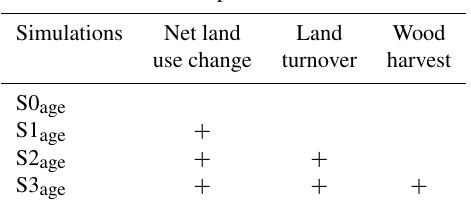
Table 4. Factorial simulations to examine forest cohort dynamics when including different LUC processes: net land use change, land turnover, and wood harvest. The plus signs ( + ) indicate that the corresponding processes (matrices) are included in the simulations. Only simulations with sub-grid age dynamics are carried out, with S0 age having no LUC activities to S3 age including all LUC pro-